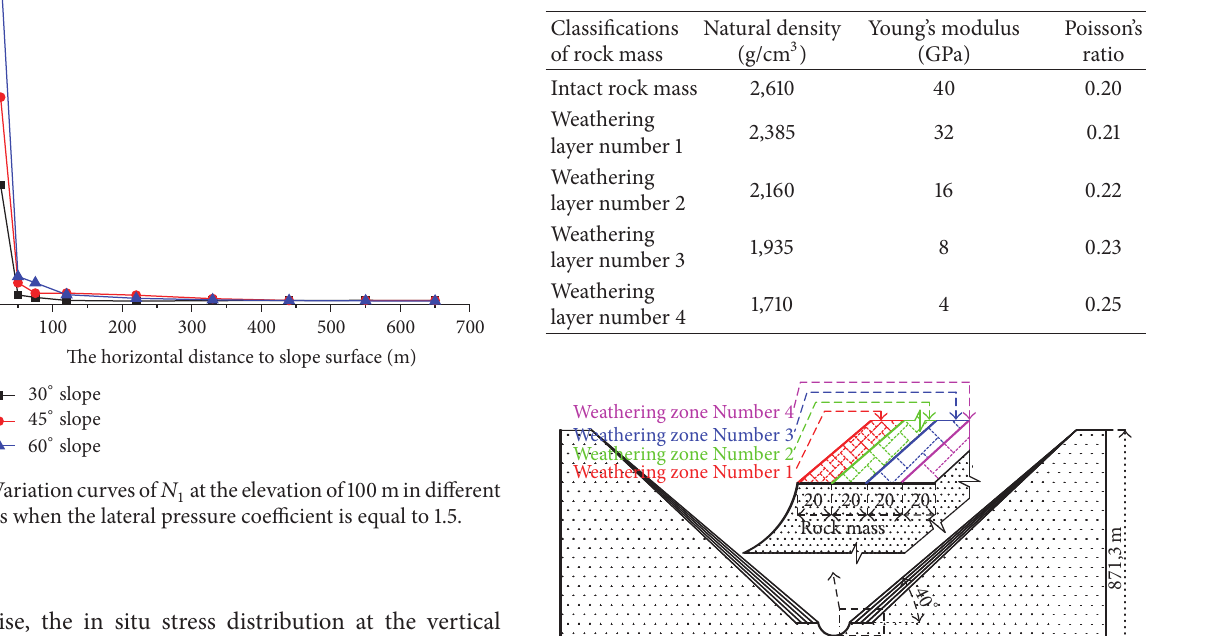
Table 2: Physicomechanical parameters of the surrounding rock mass and four weathering zones.